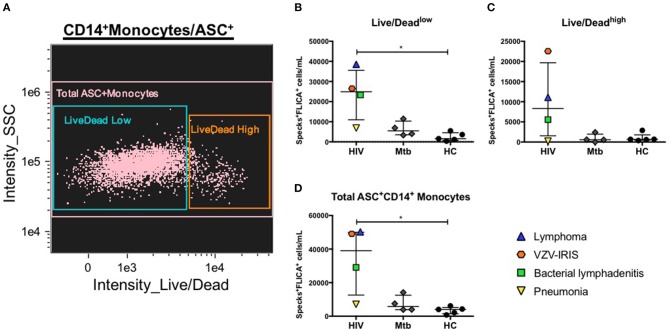
Evaluation of canonical inflammasome activation in patient samples. (A) Representative 2-parameter dot-plot fluorescence of Live/Dead (L/D–channel 8) vs. side scatter (SSC–ch12) applied after population of interest was defined as follow: single cells, focused cells, monocyte-like population (based on area and SSC), HLA-DR+, and DUMP− cells and finally CD14+ASC+ cells. Speck+FLICA+ monocytes/mL were then quantified in PBMCs from healthy controls (HC) and from patients after Area_Threshould (M11,11-ASC70) vs. Modulation_Morphology(M11,Ch11)_11-ASC dot-plot, followed by Bright Detail Similarity R3_MC_11-ASC_2-FLICA features were applied in all data inside Live/Dead AQUAlow
(B), Live/Dead AQUAhigh
(C), and total CD14+ASC+ cells (D) as defined in (A). *P < 0.05 when Mann-Whitney test was applied.